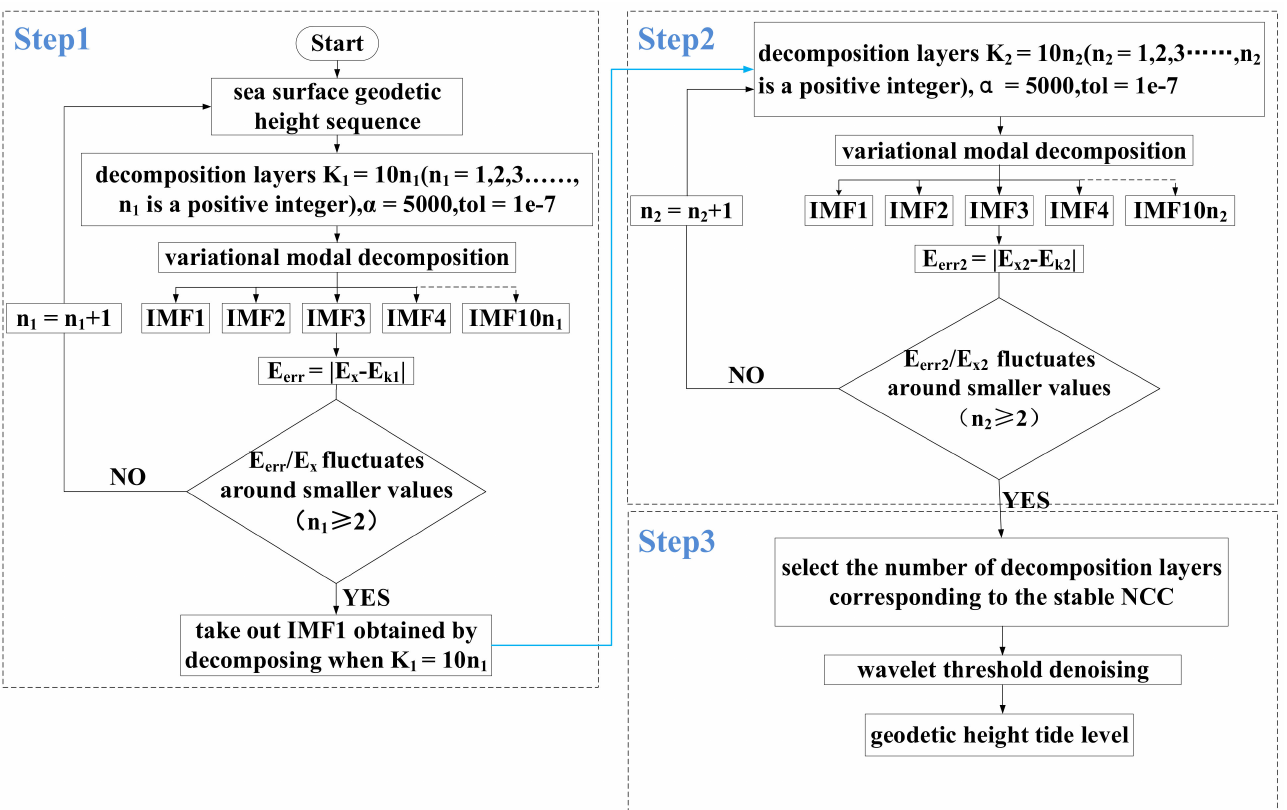
Figure 4. Flow chart of VMD–WT